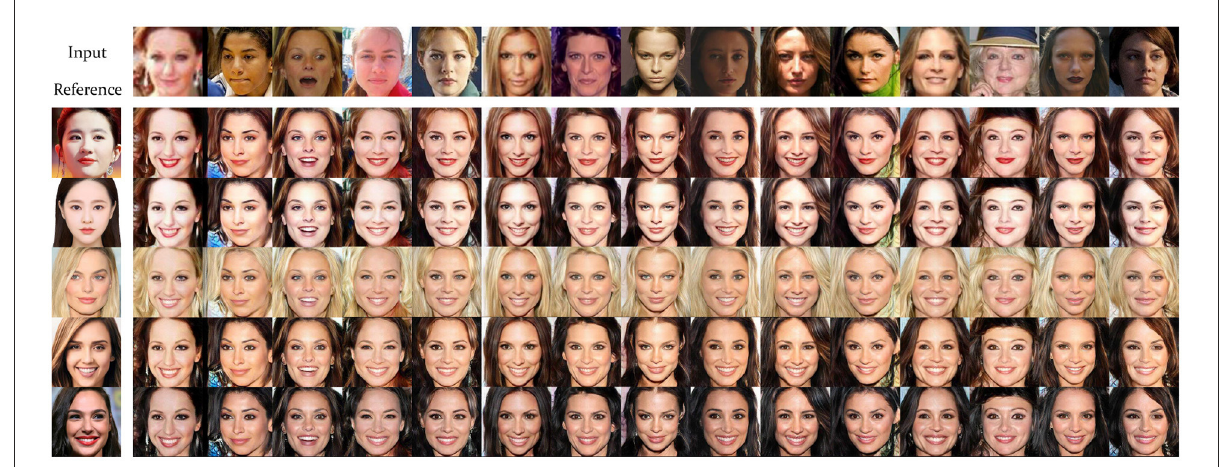
FIGURE1 Face beautification as many-to-many image translation: Our approach integrates style-based beauty representation with a beauty score prediction model and is capable of fine-granularity control.